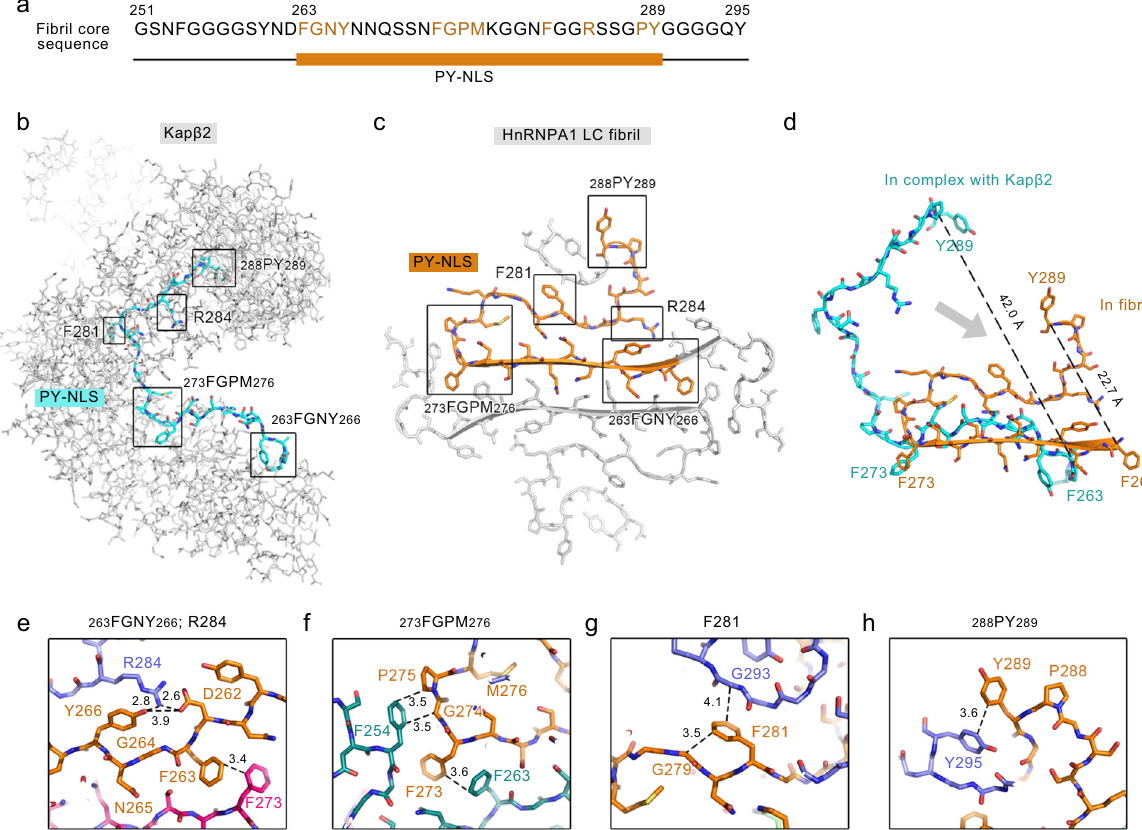
Fig. 4 Structures of PY-NLS in complex with Kap β 2 and in the hnRNPA1 LC fi bril. a The primary sequence of the hnRNPA1 fi bril core. The orange bar marks the region of PY-NLS. Residues interacting with Kap β 2 are highlighted in orange. b Complex structure of PY-NLS and Kap β 2 (PDB ID: 2H4M). PY- NLS is shown in sticks and colored in cyan. Kap β 2 is shown in gray sticks. Regions of PY-NLS interacting with Kap β 2 are framed and labeled. c Top view of one layer of hnRNPA1 LC fi bril structure. PY-NLS in one subunit is highlighted in orange. The rest of the structure is shown in gray sticks. The same framed regions of PY-NLS in b are framed and labeled. d Overlay of PY-NLS structures in complex with Kap β 2 and in fi bril. e – h Zoom-in views of the framed regions in c . HnRNPA1 LC subunits are colored differently. Distances between side chains are indicated in